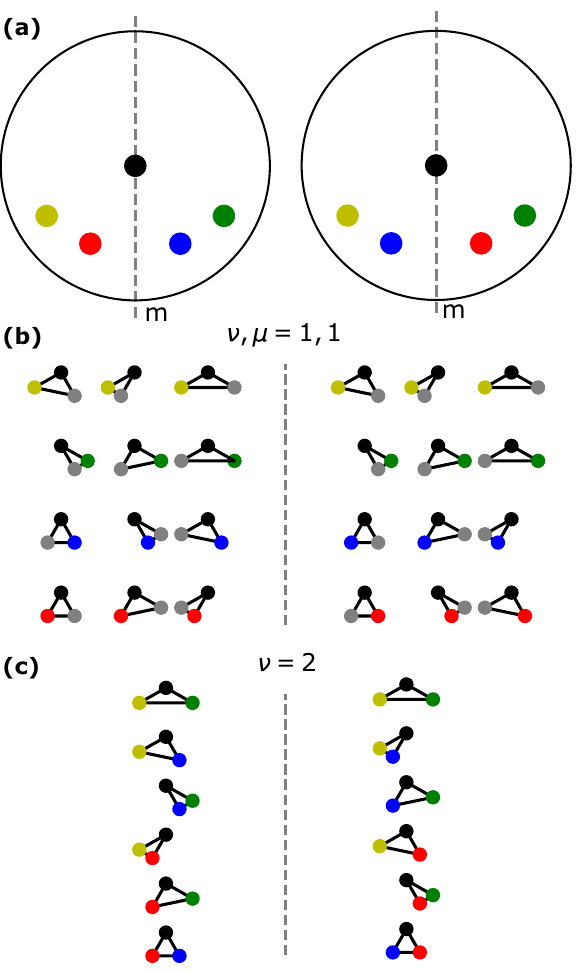
Fig. 3 Pair of degenerate environments. Two environments which are distinct using ν = 2 but identical according to ν , μ = 1, 1, because of the mirror symmetry of the total density, are shown. Elements are distinguished by colour whilst the histograms of triangles shown on the right - element agnostic vertices are shown in